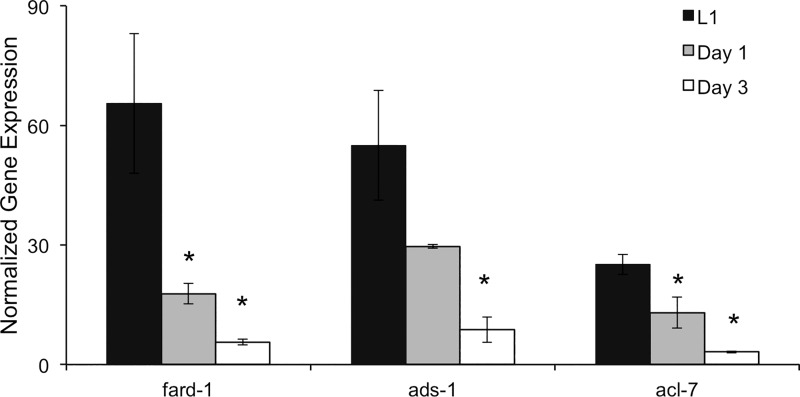
Expression of Ether-Lipid Synthesis Genes is Greatest in Larvae.In wild-type nematodes, the expression of fard-1 is significantly lower in day 1 (grey) adults and day 3 (white) adults when compared to L1 animals (black). A separate analysis was performed to assay the expression of two additional ether lipid biosynthetic genes, acl-7 and ads-1. The statistical significance was determined by one-way ANOVA with significant differences (p<0.05) being indicated by *. Data is a result of at least 3 biological replicates with SEM shown.